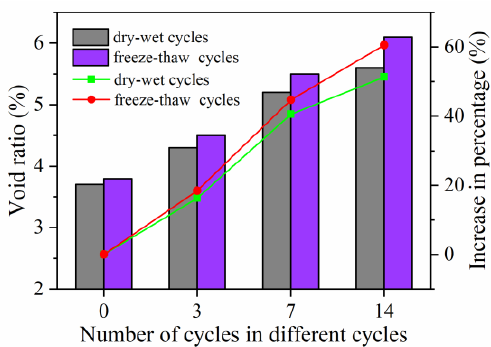
Figure 11. Variation in void ratio with the number of cycles under varying numbers of cycles.